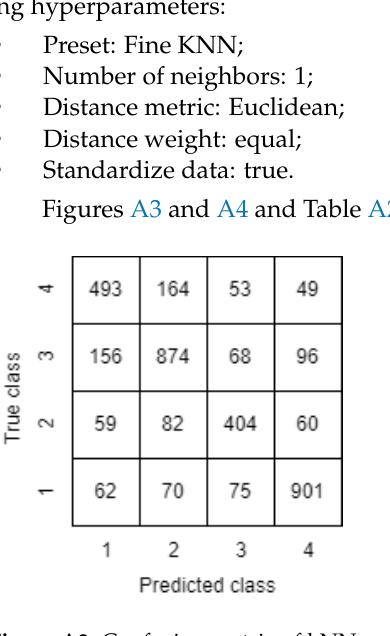
Figure A3. Confusion matrix of kNN.